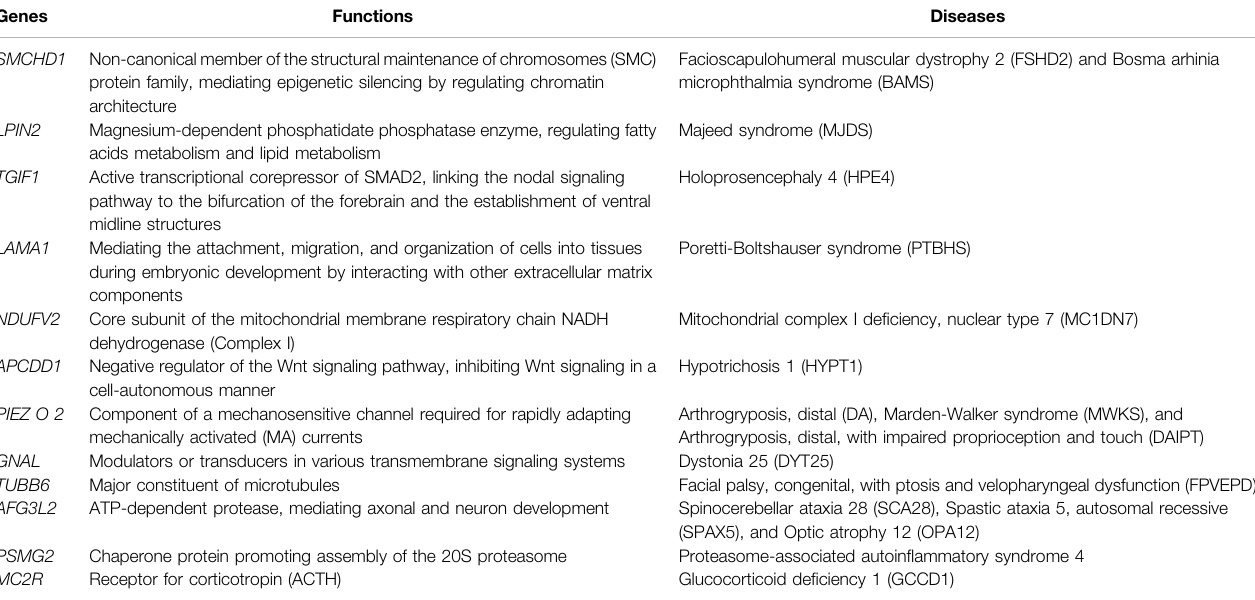
TABLE 1 | The main functions and associated diseases of the 12 genes in the deletion region of 18p identi fi ed by WGS.